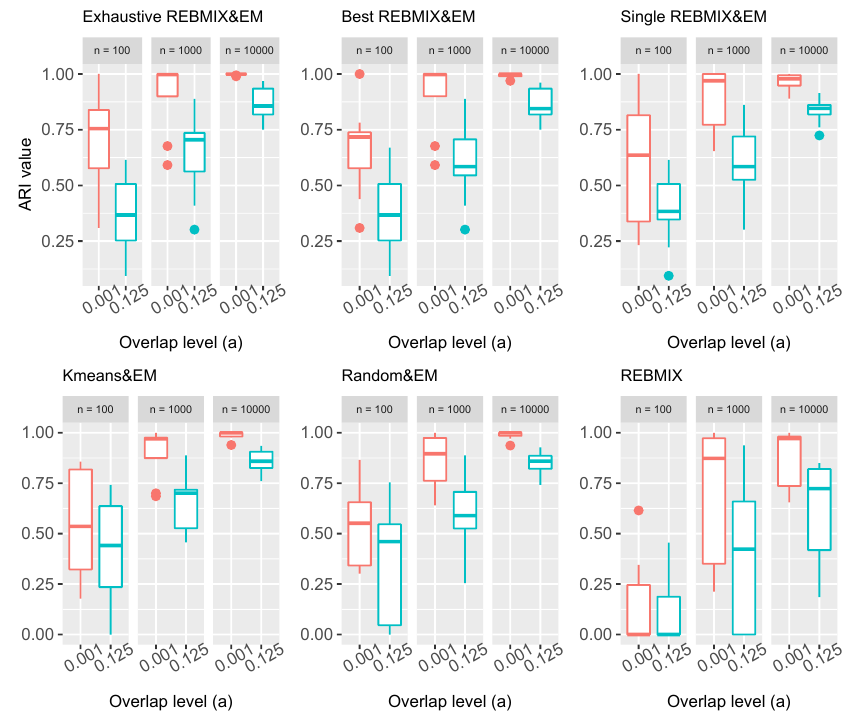
Figure 5. Clustering performance of the Exhaustive REBMIX&EM strategy, Best REBMIX&EM strategy, Single REBMIX&EM strategy, Kmeans&EM, Random&EM, and REBMIX on artificial